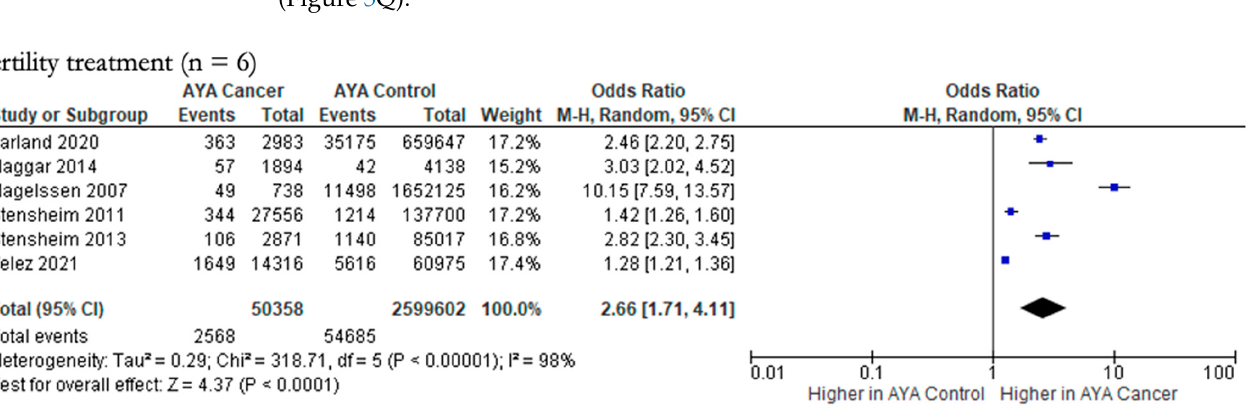
Figure 8. Forest plot for maternal-paternal health outcome reported by two or more studies (n =